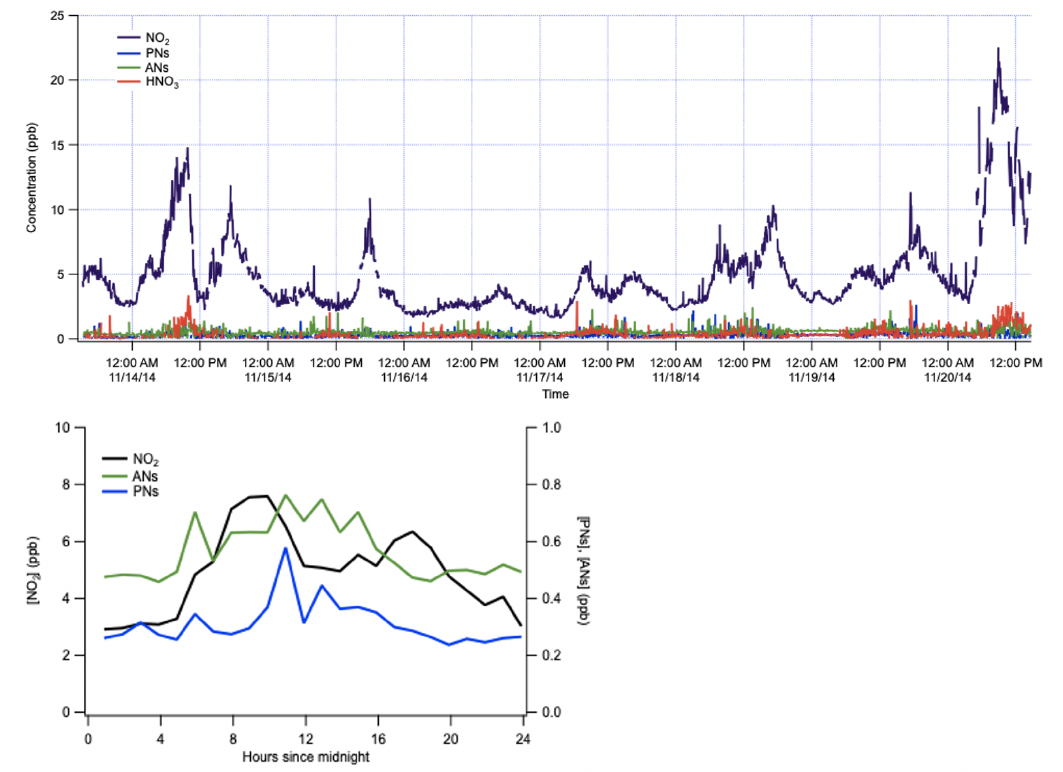
Figure 9. Representative measurements of NO 2 , PN, AN, and HNO 3 concentrations from ambient air in November 2014 in Portland, OR. One week of data is shown to illustrate measurements of typical variability, alongside an average diurnal cycle from this period.